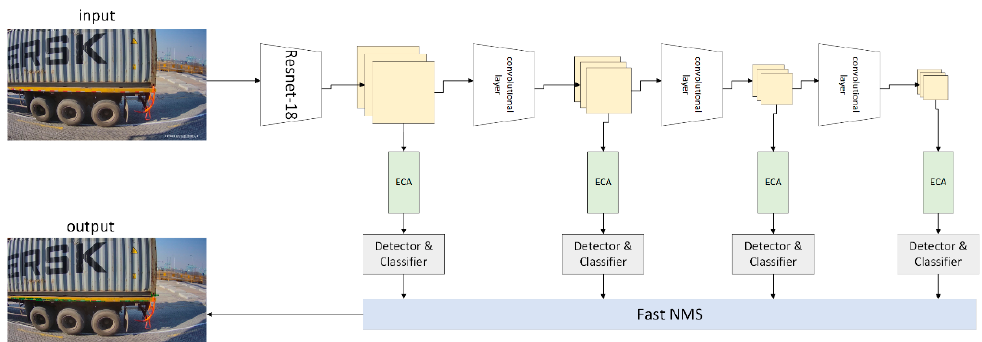
Figure 4. R-E-SSD network structure. ECA-Net, a lightweight and efficient channel attention module, ensures the neural network focuses on certain channels with large weight values, and resnet-18 provides the feature extraction backbone network.